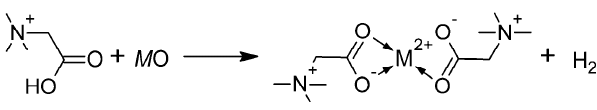
Figure 4. Dissolution mechanism of a metal oxide in [Hbet][NTf 2 ].